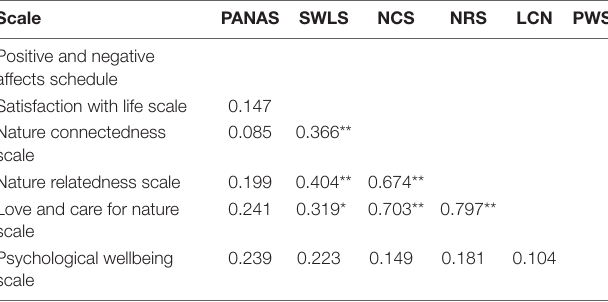
TABLE 4 | Variable